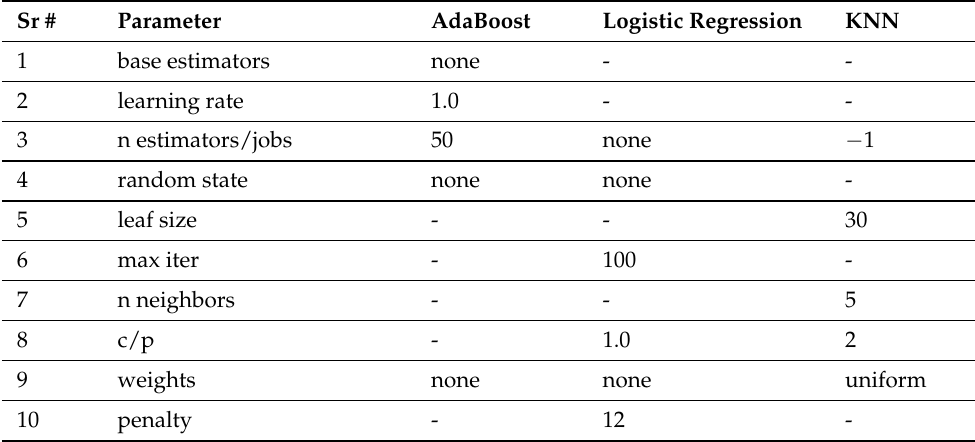
Table 1. Hyperparameter settings for the base and